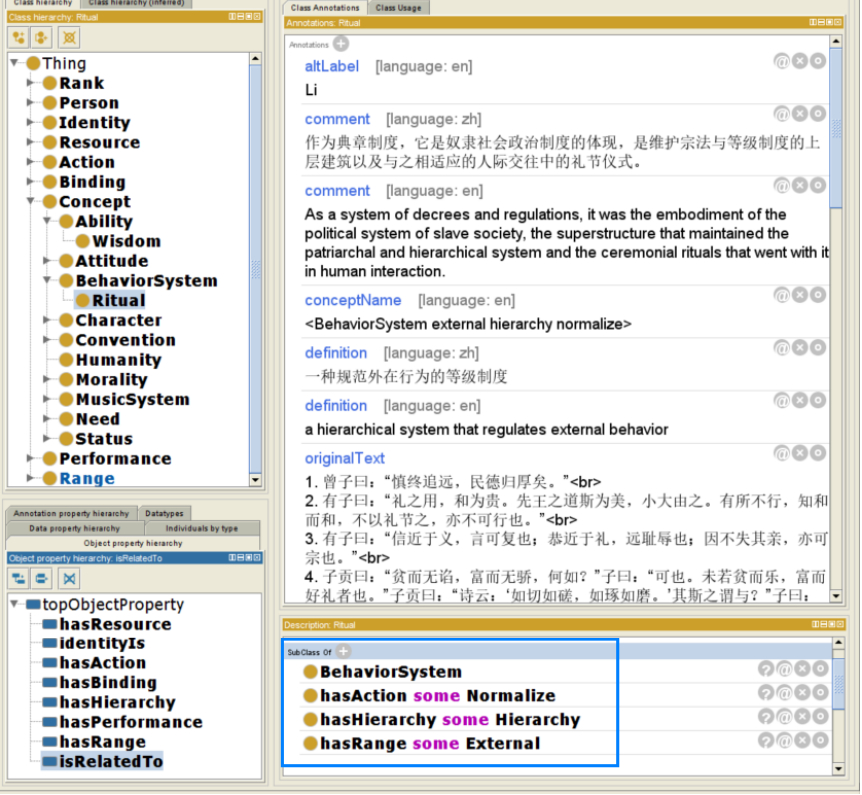
Figure 3. The “Ritual” as a class. Li ≡ BehaviorSystem ⊓ ∃ hasAction. Normalize ⊓ ∃ hasRange. External ⊓ ∃ hasHierar- chy. Hierarchy